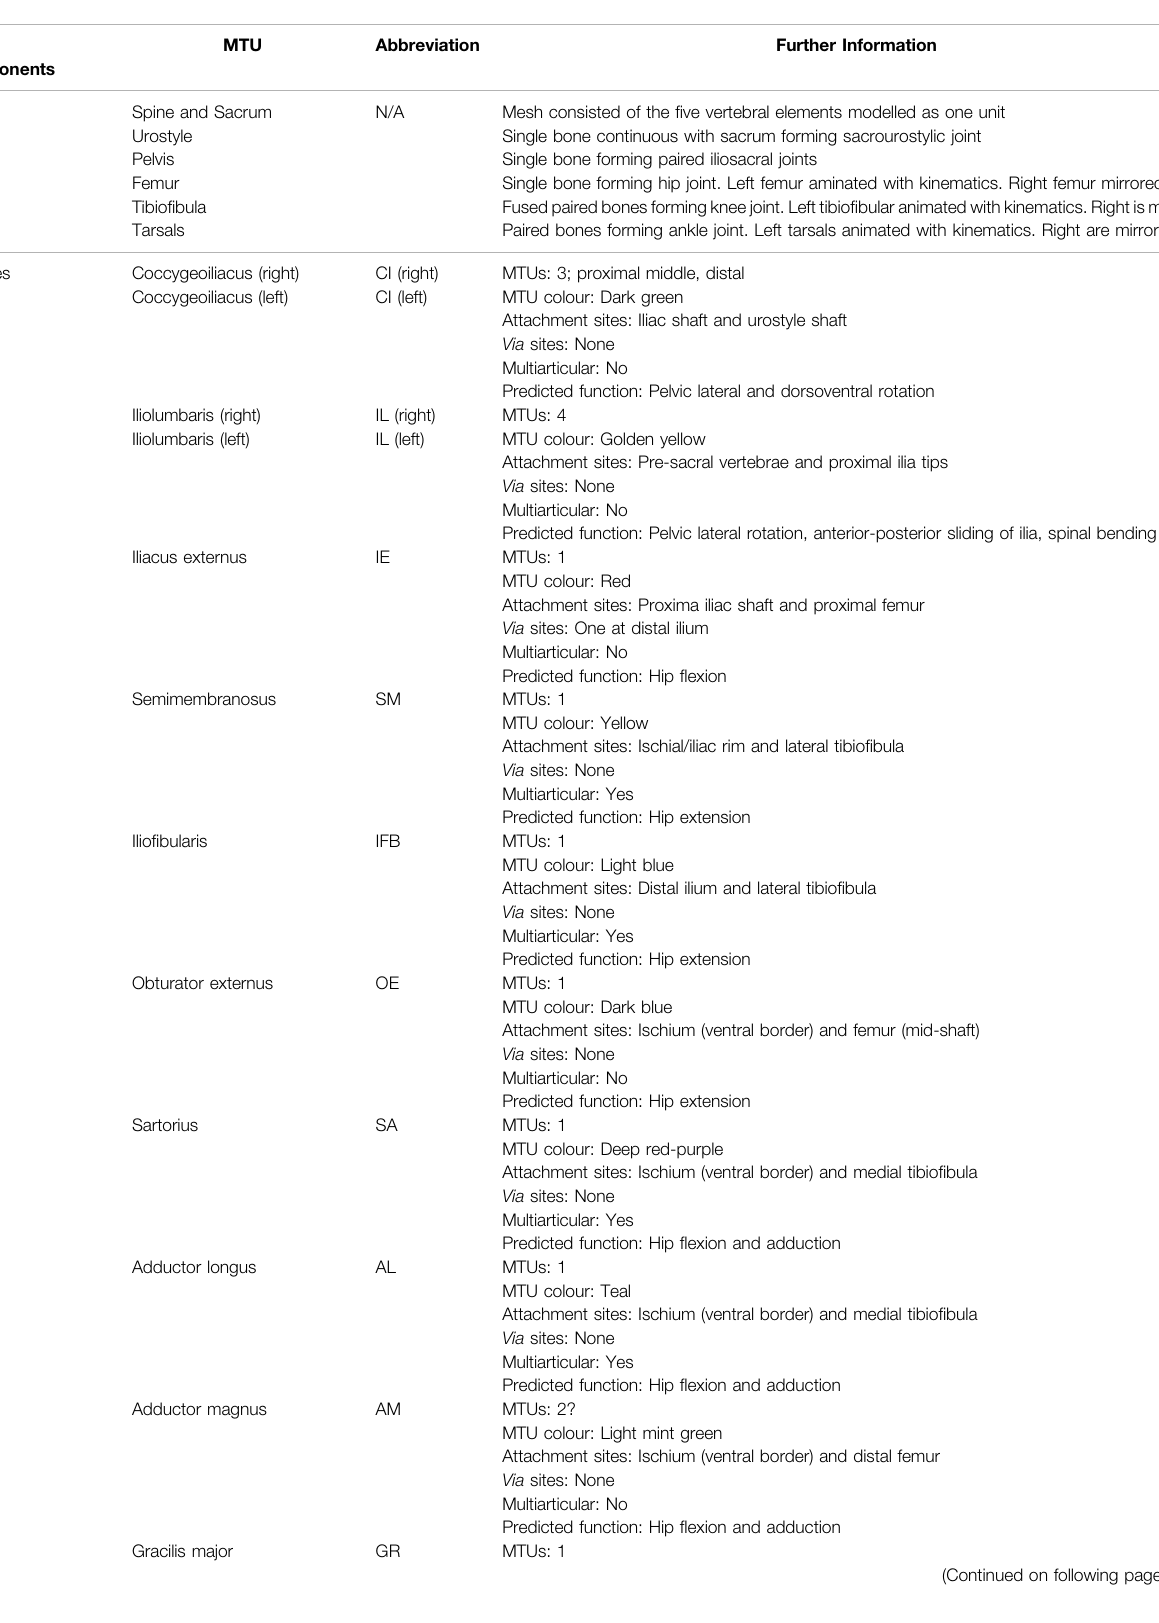
TABLE 1 | A summary table listing the bones, muscles, and joints modelled. Note the predicted functions of the muscles are based on published data from P ř ikryl et al. (2009). Model Components